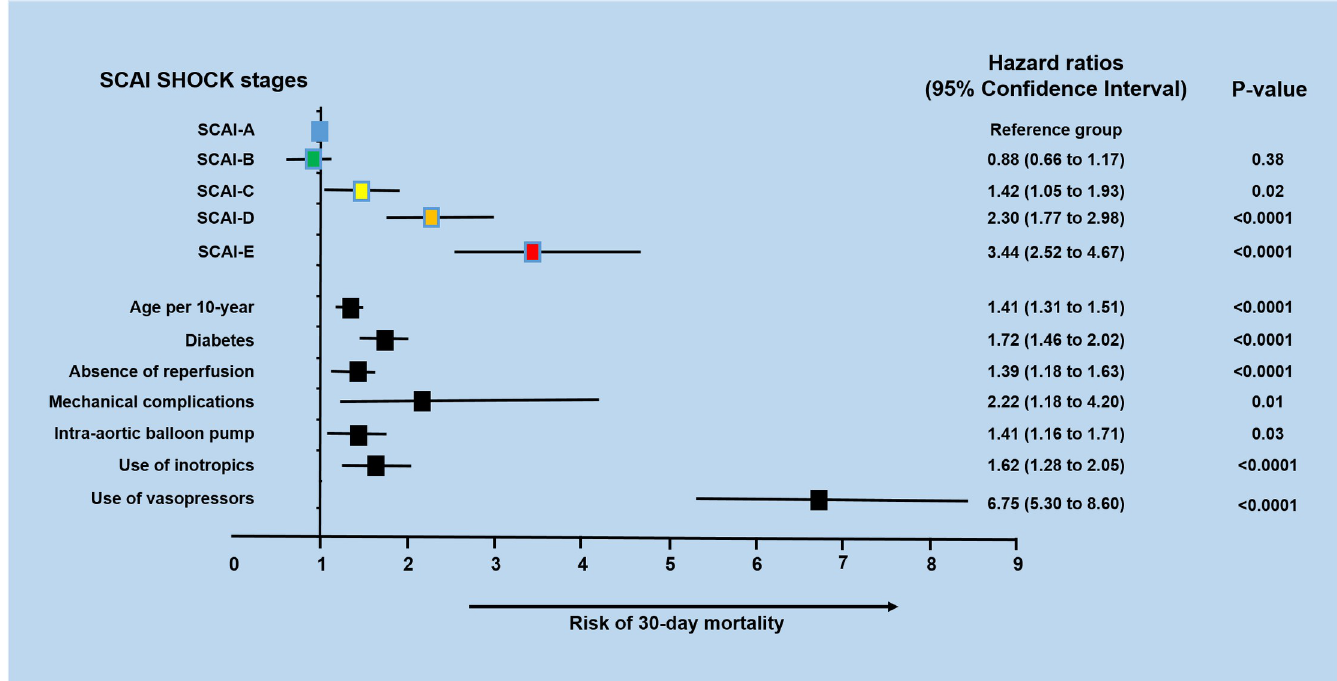
Fig 4. Adjusted hazard ratio for 30-day mortality demonstrating adjusted associations between SCAI shock stages with 30-day mortality.